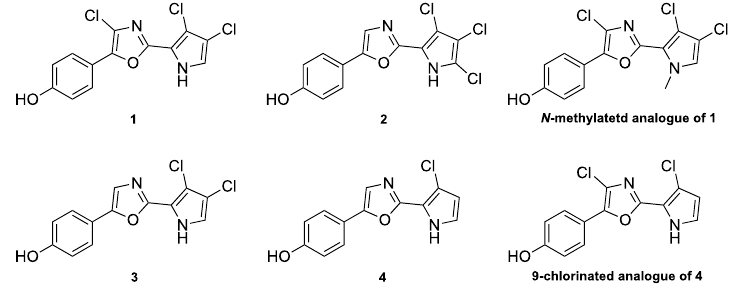
Figure 1. Phorbazoles A–D ( 1 – 4 ).